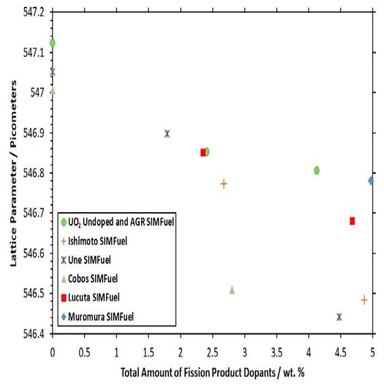
Variation of the lattice parameter as a function of total dopant wt.% for undoped UO2, 25 and 43 GWd/tU AGR SIMFuels and CANDU/LWR SIMFuel samples created by Lucuta et al., Ishimoto et al. ., Une and Oguma , Muromura et al. . and Cobos et al. .